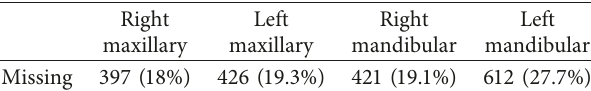
Table 3: First molar missing in four quadrants. Right